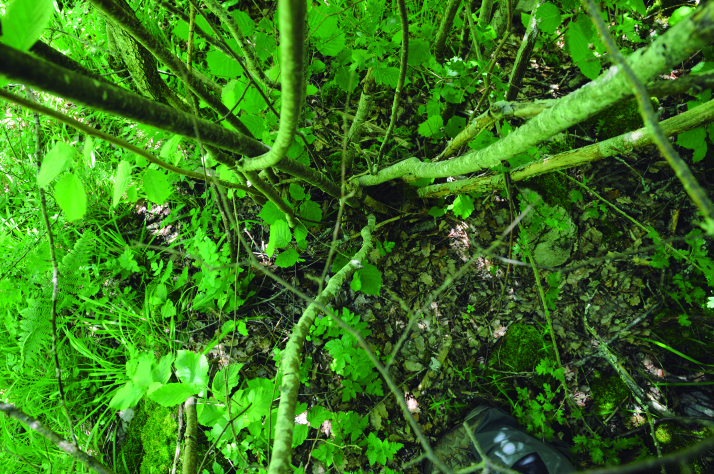
P4 plot El Canto, Q.
faginea forest (detail leaflitter)